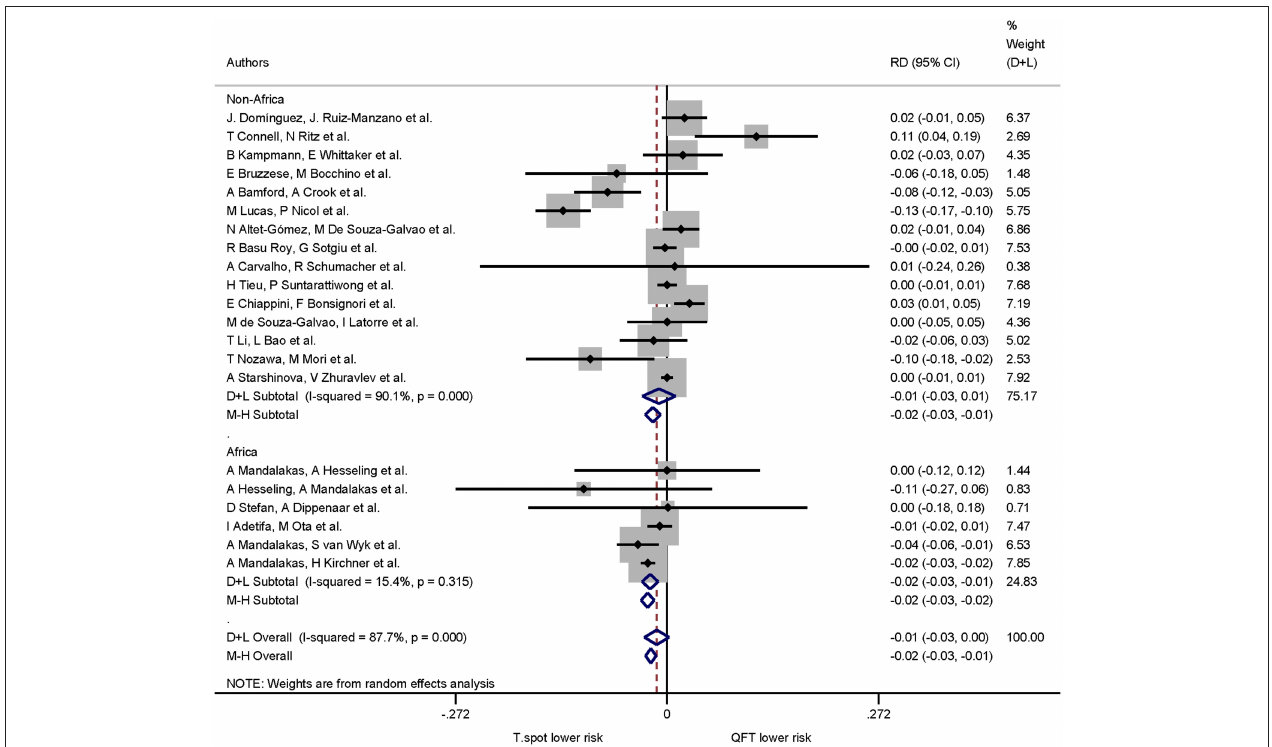
FIGURE 6 | Risk differences (RD) with 95% CI in studies that included a head-to-head comparison of QuantiFERON-TB and T-SPOT.TB assays stratified by African/Non-African origin of the study. Studies arranged according to year of publication.